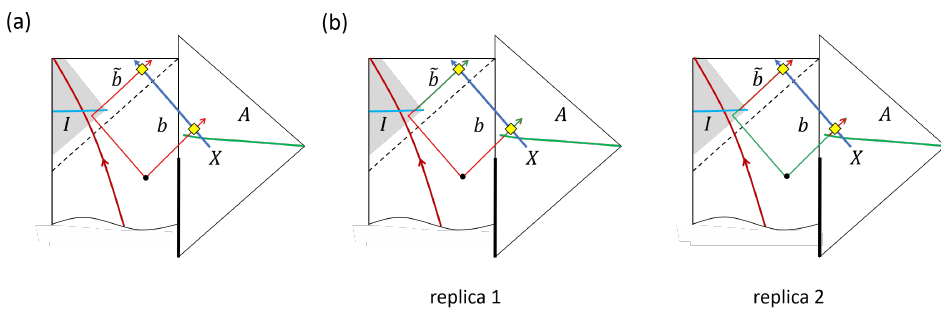
Figure 7 . (a) Illustration of a pair of qubits b, ˜ b with ˜ b ∈ I, b ∈ A . An infalling observer X (cid:12) ˜ b (cid:11) is in a particular maximally entangled states such as |−i . (b) Illustration measures whether (cid:12) b